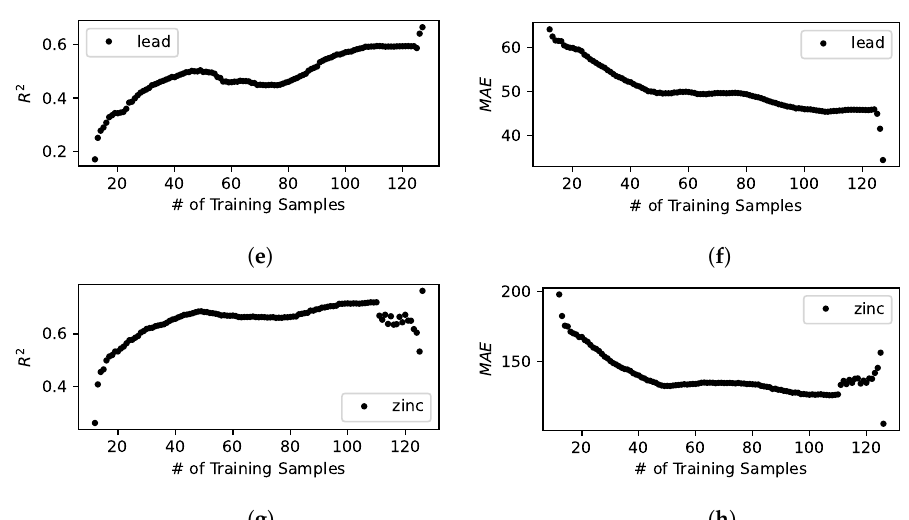
Figure 4. Standalone prediction model built with active learning. The figures show R 2 and MAE for predicted heavy metal concentrations on the evaluation data set. ( a ) R 2 for predicted cadmium concentration; ( b ) MAE for predicted cadmium concentration; ( c ) R 2 for predicted copper concentra- tion; ( d ) MAE for predicted copper concentration; ( e ) R 2 for predicted lead concentration; ( f ) MAE for predicted lead concentration; ( g ) R 2 for predicted zinc concentration; ( h ) MAE for predicted zinc concentration.